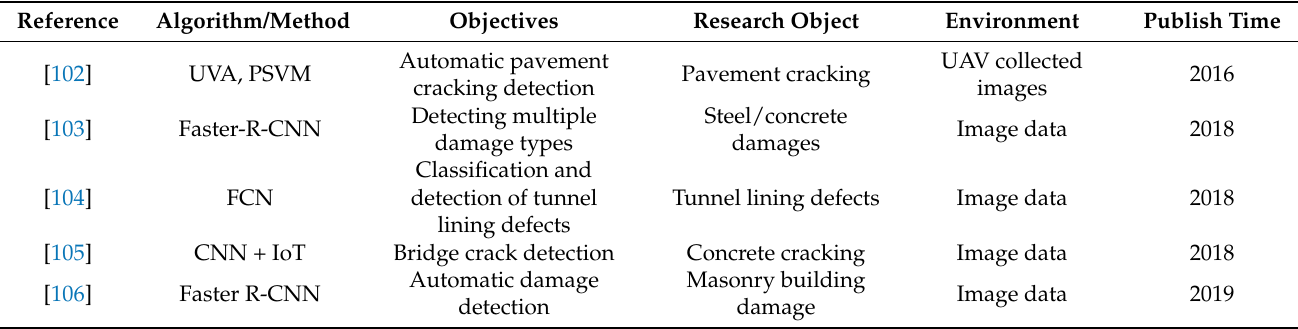
Table 7. Computer vision applications in damage